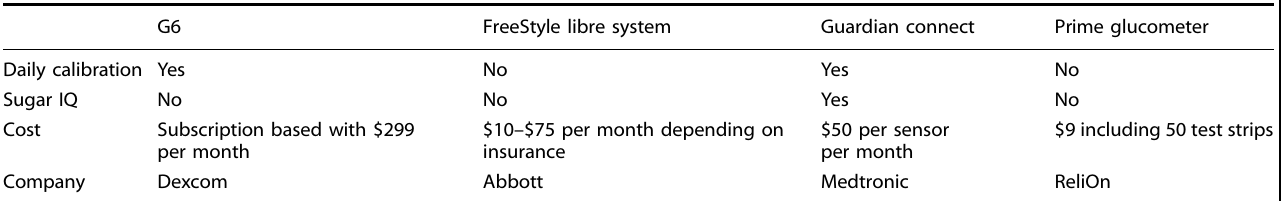
Table 3. Commercially available glucometers.